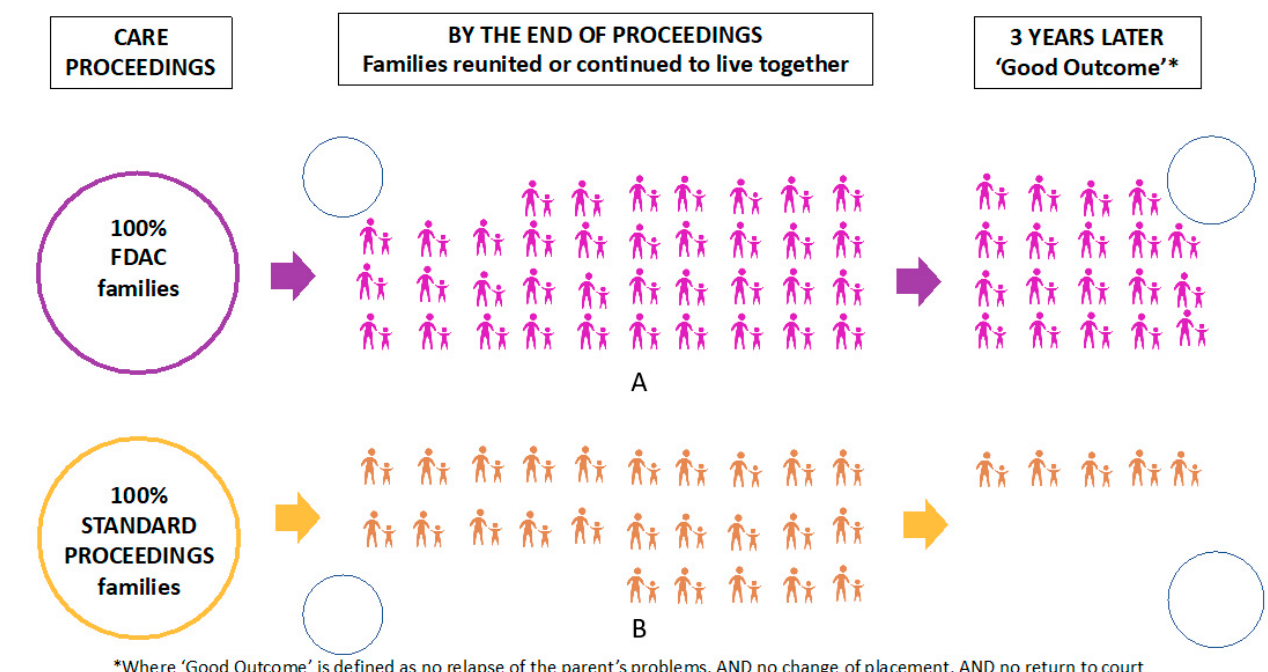
Figure 1. Outcomes by the end of proceedings and 3 years later.